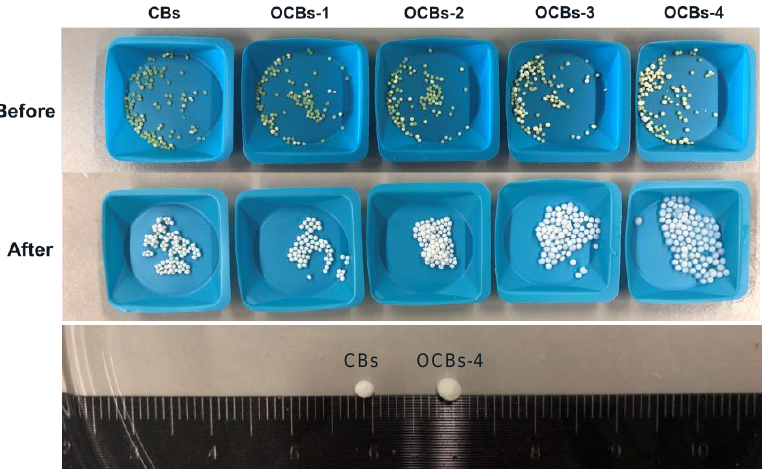
Figure 8. (Top) The appearance of IND-loaded CBs and OCBs before and after drug release. (Bottom) Different swelling degrees of CBs and OCBs-4 after drug release at pH = 7.0.